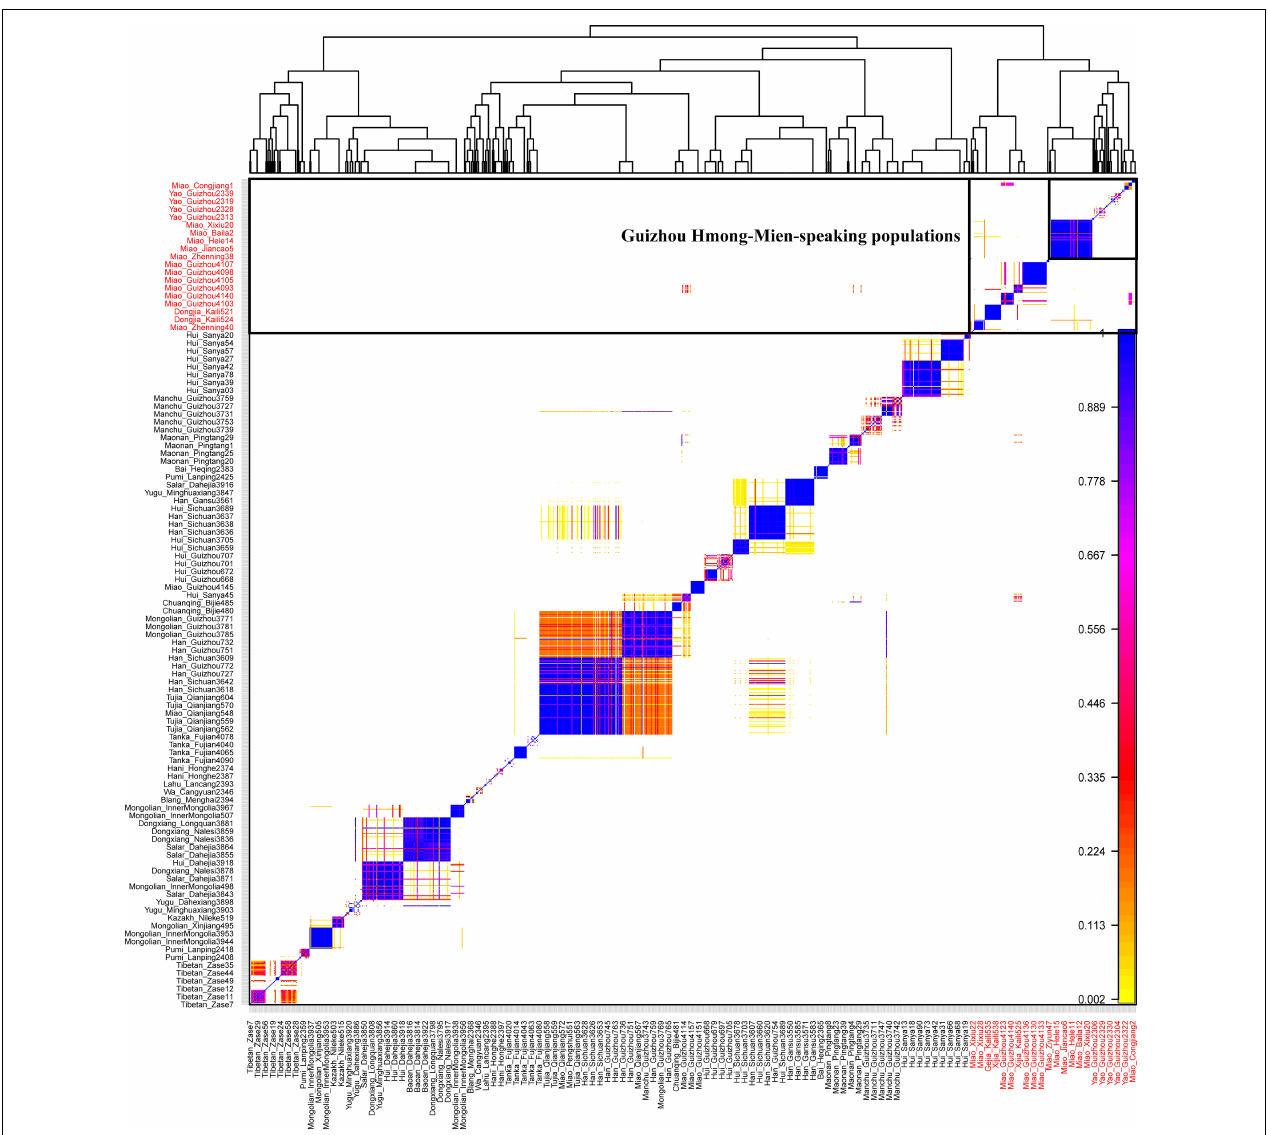
FIGURE 4 | Fine-scale population structure based on the pairwise coincidence matrix among 1,049 Chinese individuals. Newly focused Hmong-Mien-speaking population is marked with red